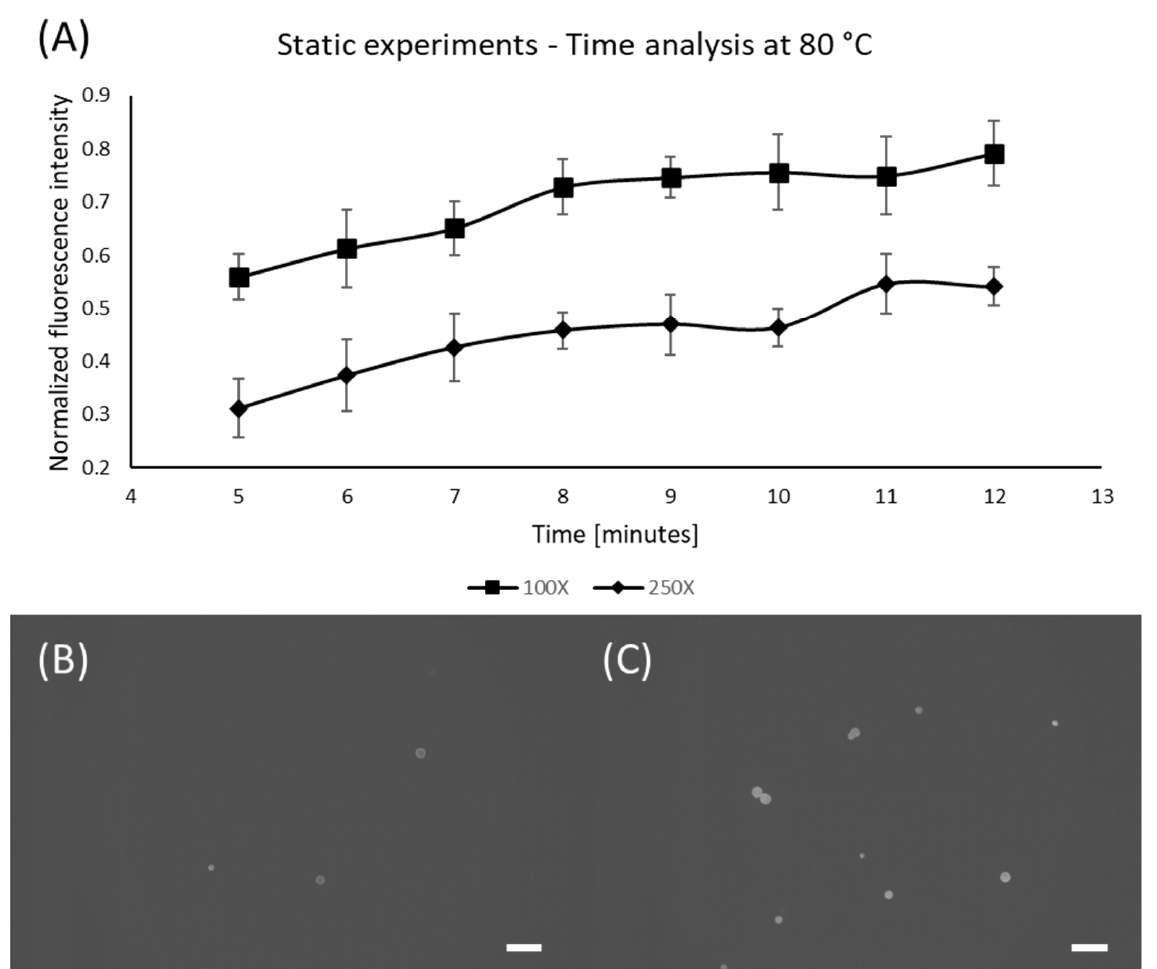
Figure 4. Effect of time for 100X and 250X Nile Red solutions at 80 °C. ( A ) Graph showing the influence of time; ( B ) PE microspheres stained using 100X Nile Red for 5 min; ( C ) PE microspheres stained using 100X Nile Red for 12 min; Scale bars are 100 µm.